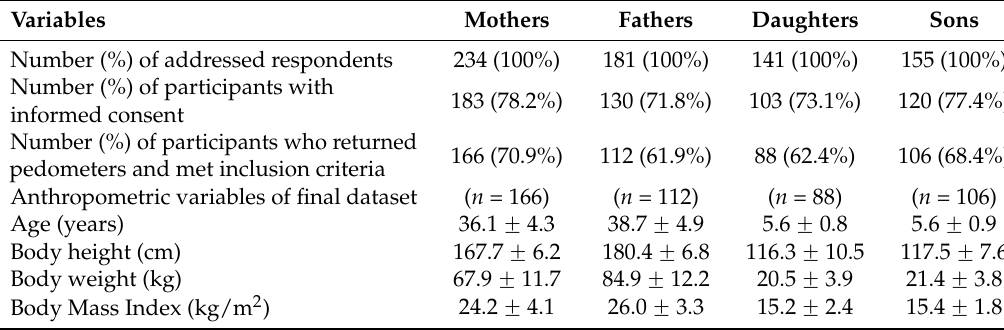
Table 1. Descriptive characteristics (number; %; means and standard deviations) of